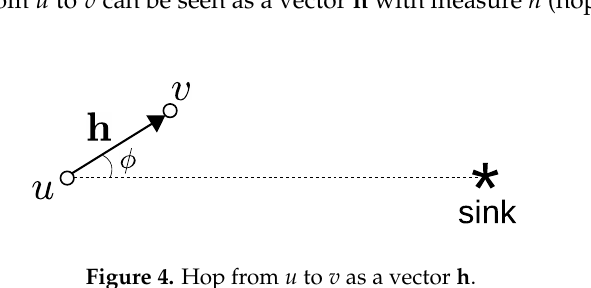
Figure 4. Hop from u to v as a vector h .